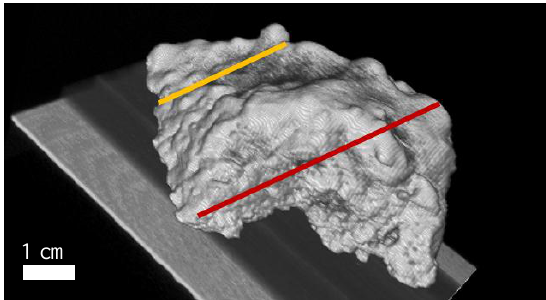
Figure 2. Volume reconstruction of sample A based on X-ray tomography.